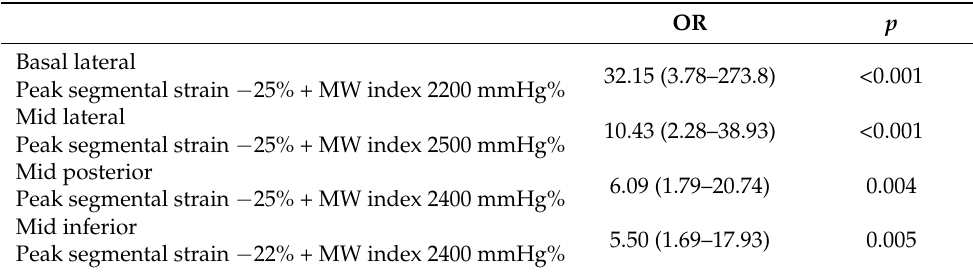
Table 6. Univariate logistic regression analysis for a combination of peak segmental strain and MW index (for the pre-specified cut-off values) as predictors of the primary end-point. OR p Basal lateral